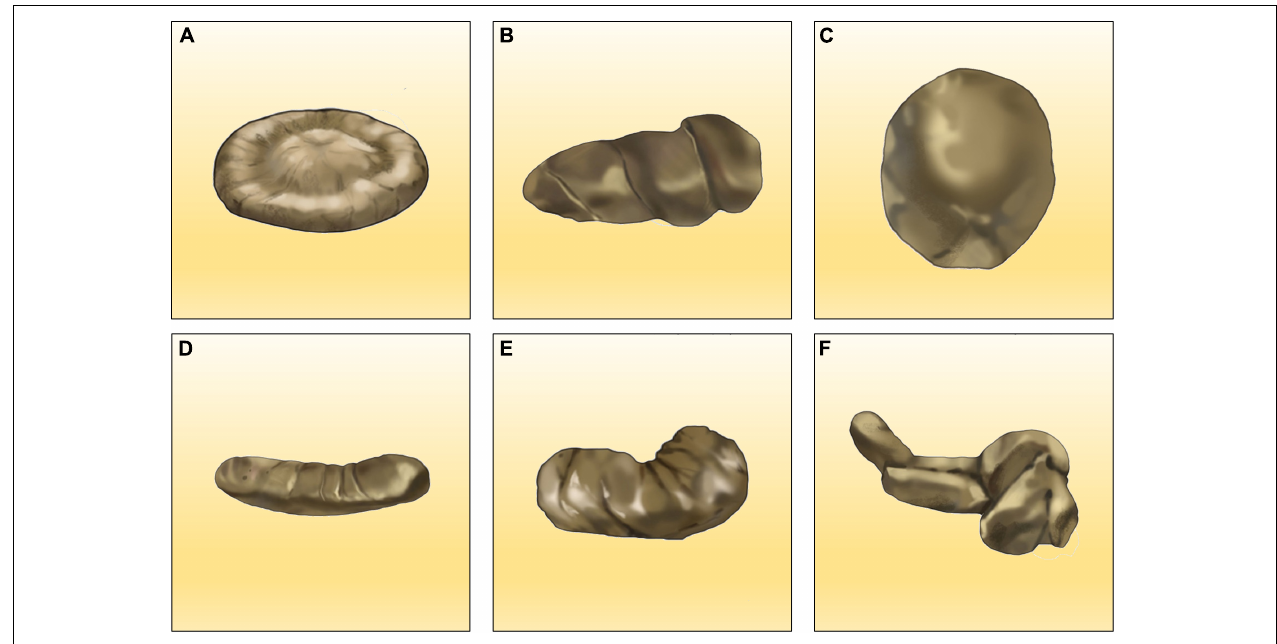
FIGURE 1 | Classification of coprolites by morphology. (A) Discoidal; (B) spiral; (C) round; (D) rod-like; (E) kidney-shaped; (F)